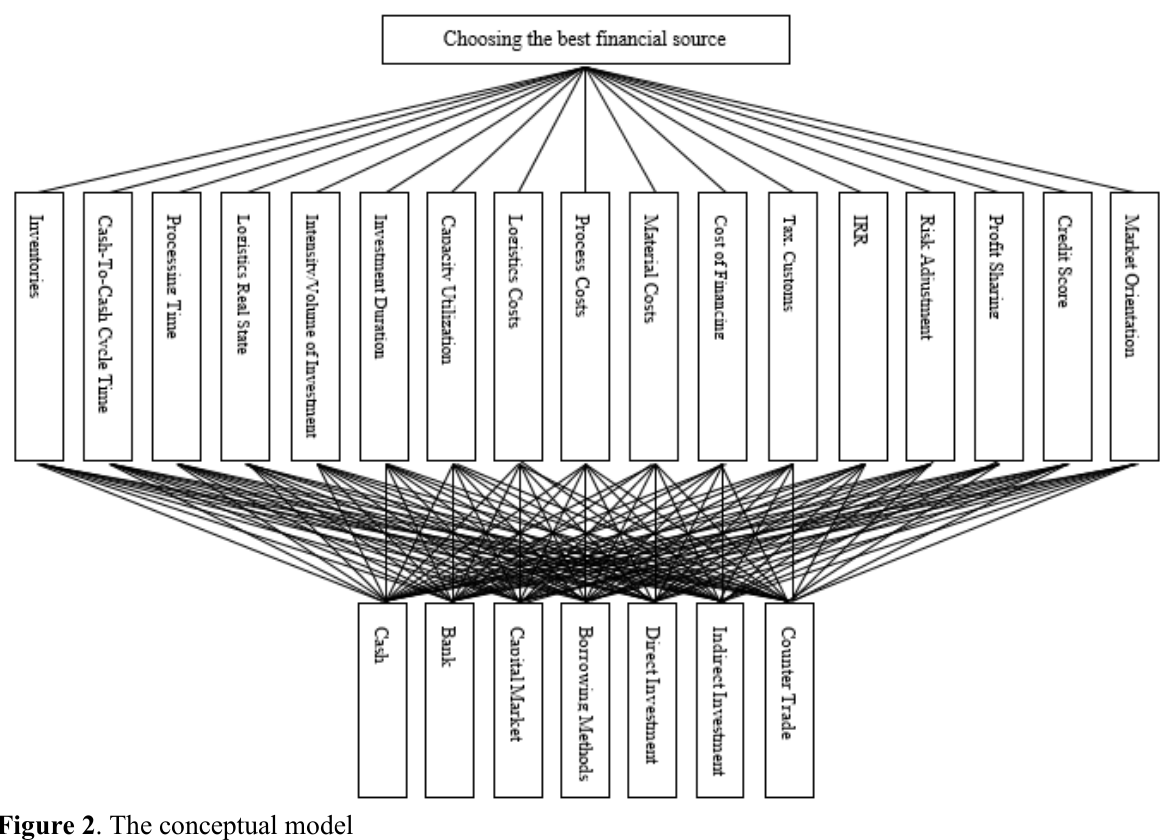
Figure 2 . The conceptual